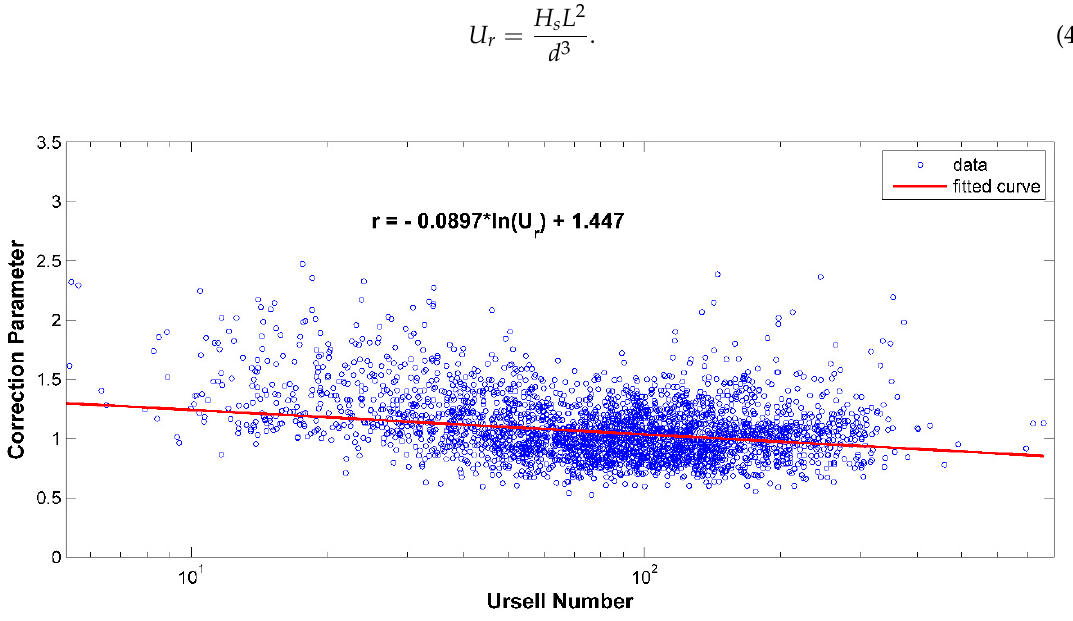
Figure 4. Relationship between the correction coefficient and the Ursell number.